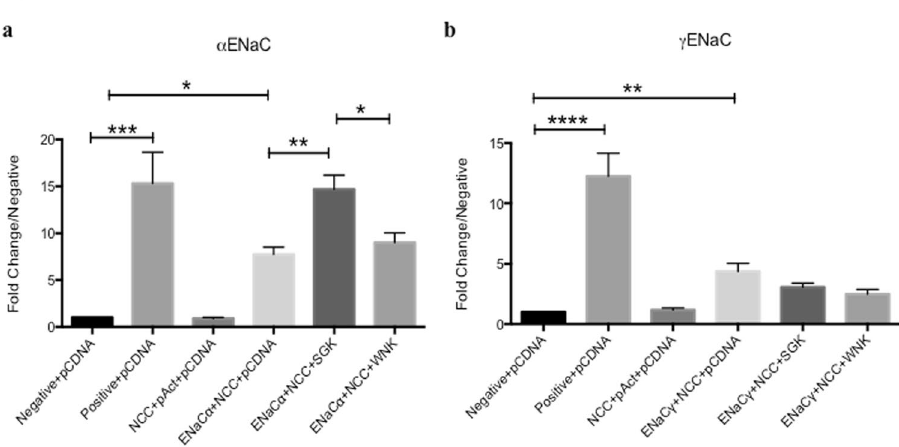
Figure 4. Mammalian two-hybrid demonstrates direct SGK1-mediated NCC and ENaC interaction. Mammalian two-hybrid assay performed on transiently transfected COS-7 cells with: empty vectors (pBIND, pACT), positive (Myo-pAct + Id-pBIND) and/or NCC-pBIND, α ENaC (4A) or γ -pAct (4B), SGK1 or WNK4. Empty vector pCDNA was used to normalize for total amounts of DNA transfected. COS-7 cells lysed and values of Firefly and Renilla luciferase obtained. Firefly luciferase data were normalized to Renilla and all data expressed as fold change of negative control group (empty vector pBIND + pAct). Data represented as mean ± SEM, n = 7–12, at least 3 separate experiments: ( a ) ANOVA, * p < 0.05, ** p < 0.01, *** p < 0.0001, ( b ) Kruskal-Wallis, ** p < 0.01, **** p <